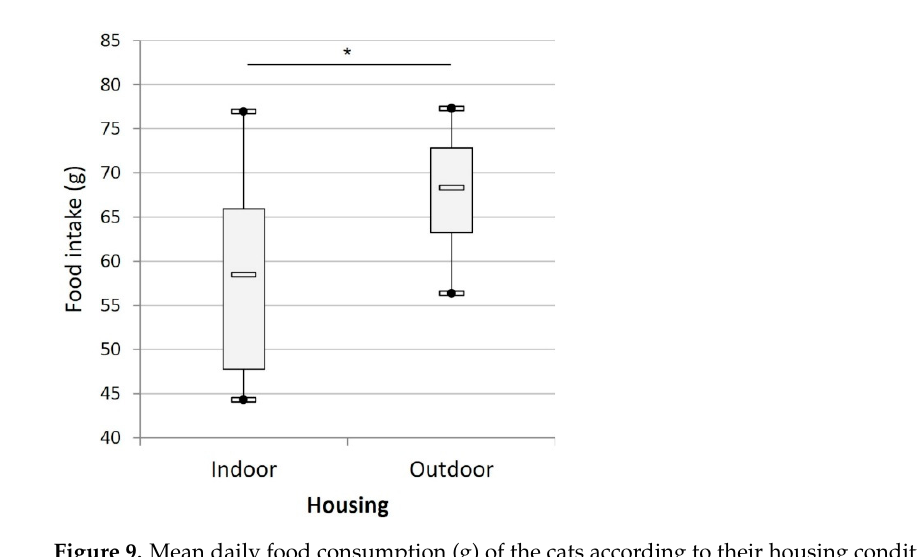
Table 2. Time of onset of the Least active feeding 5 h of the cats according to their housing condition. (+) represents one cat.